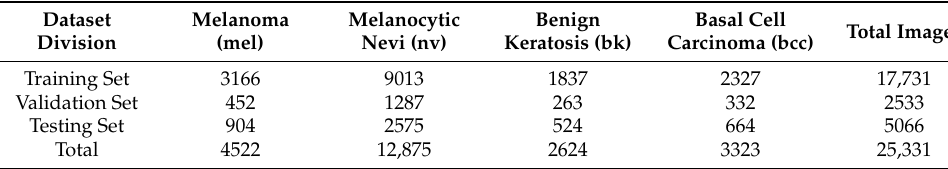
Figure 2. Sample images from the ISIC 2019 dataset . Table 1. Dataset division into training, validation and testing Table 1. Dataset division into training, validation and testing sets.